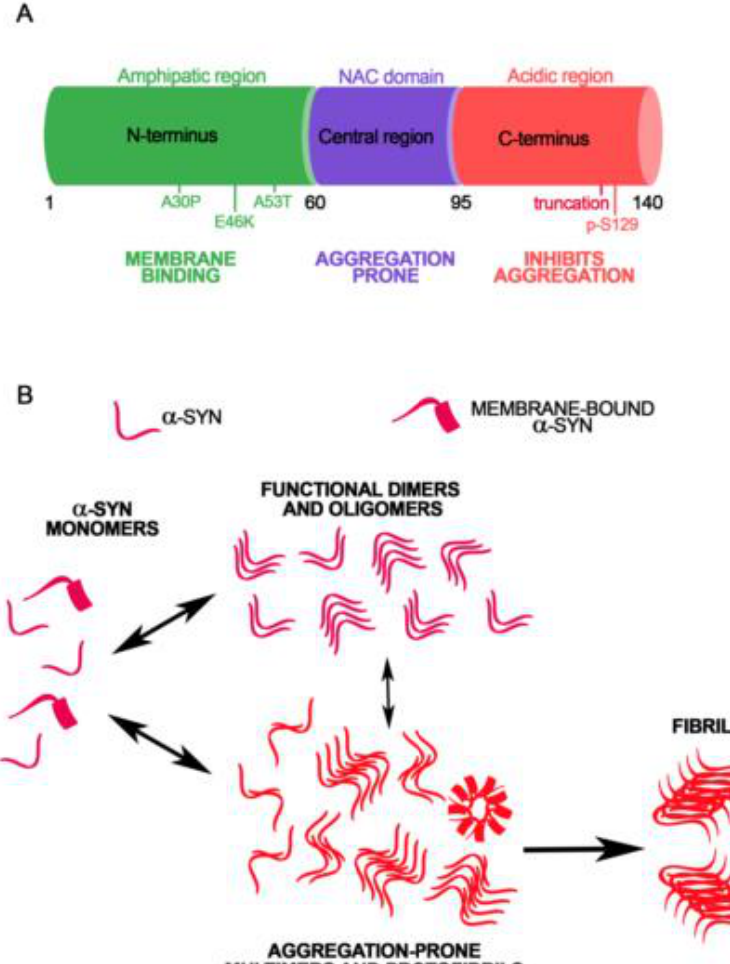
Figure 1. Amino acid sequence and conformational variability of α -synuclein ( A ). The primary amino acid sequence of α -syn can be divided in three main regions: the N-terminal amphipatic domain, the central part containing the NAC sequence and the C-terminal acidic tail. Pathogenic mutations related to familiar forms of PD and the S129 phosphorylation site are also represented ( B ). The elevated structural plasticity of α -syn can give rise to the formation of functional dimers, tetramers and oligomers or high molecular weight aggregation-prone oligomers, protofibrils and fibrils.